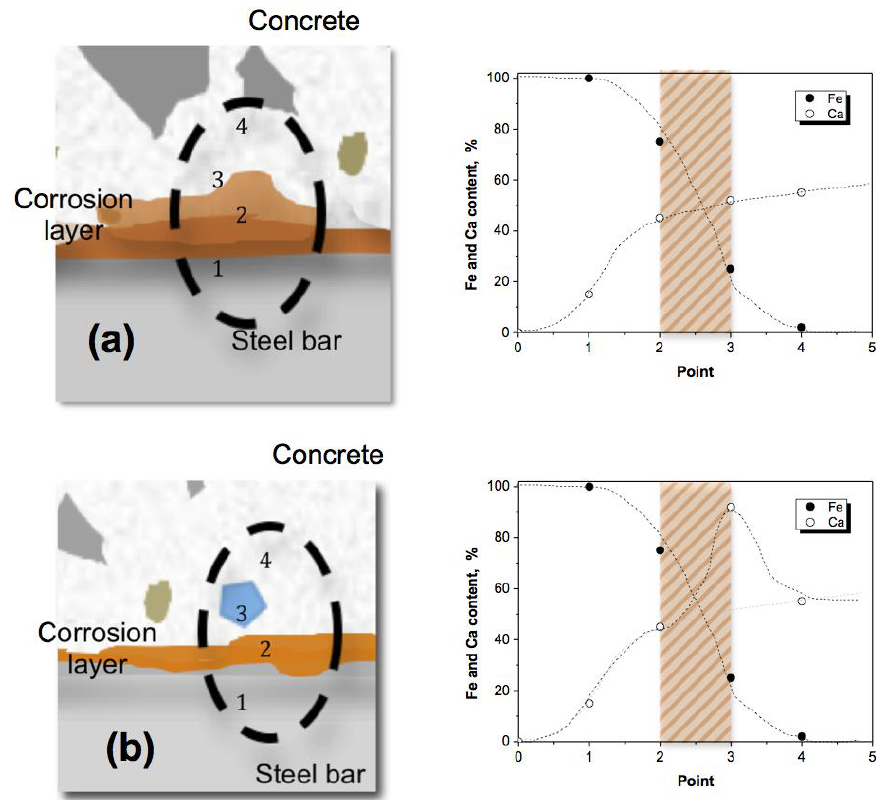
Figure 16. Schematic representation of Fe and Ca ions at transversal section between bar and con- crete containing: ( a ) corrosion layer and corrosion-filled paste and ( b ) containing ES particle. Points #1, 2, 3 and 4 inside ( a , b ) corresponding with points of the right part of the figure.